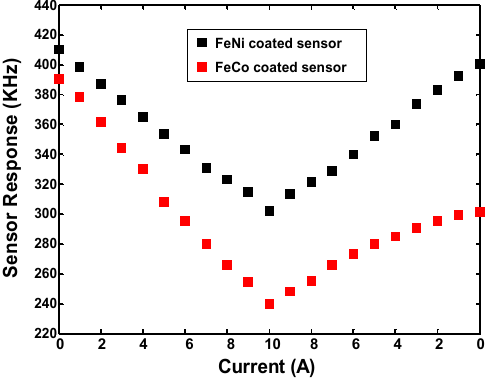
Figure 15. The symmetry test of the FeNi coated sensor and in comparison to FeCo coated sensor.